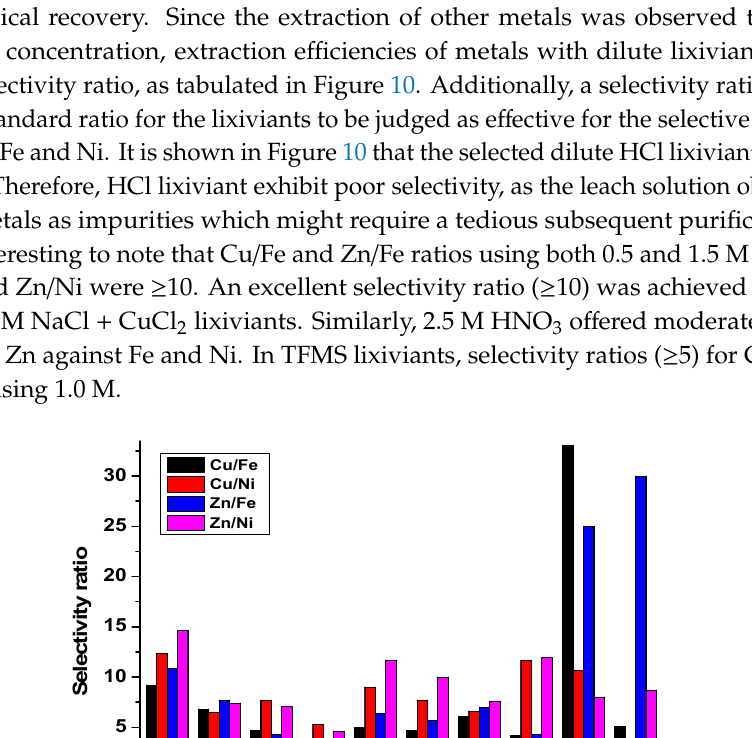
Figure 9. Comparative extraction efficiencies of Cu and Zn, and the co-extraction of other metals from WPCBs using NaOH lixiviant, 50 g/L pulp density, 25 °C, 300 rpm, and 12 h.